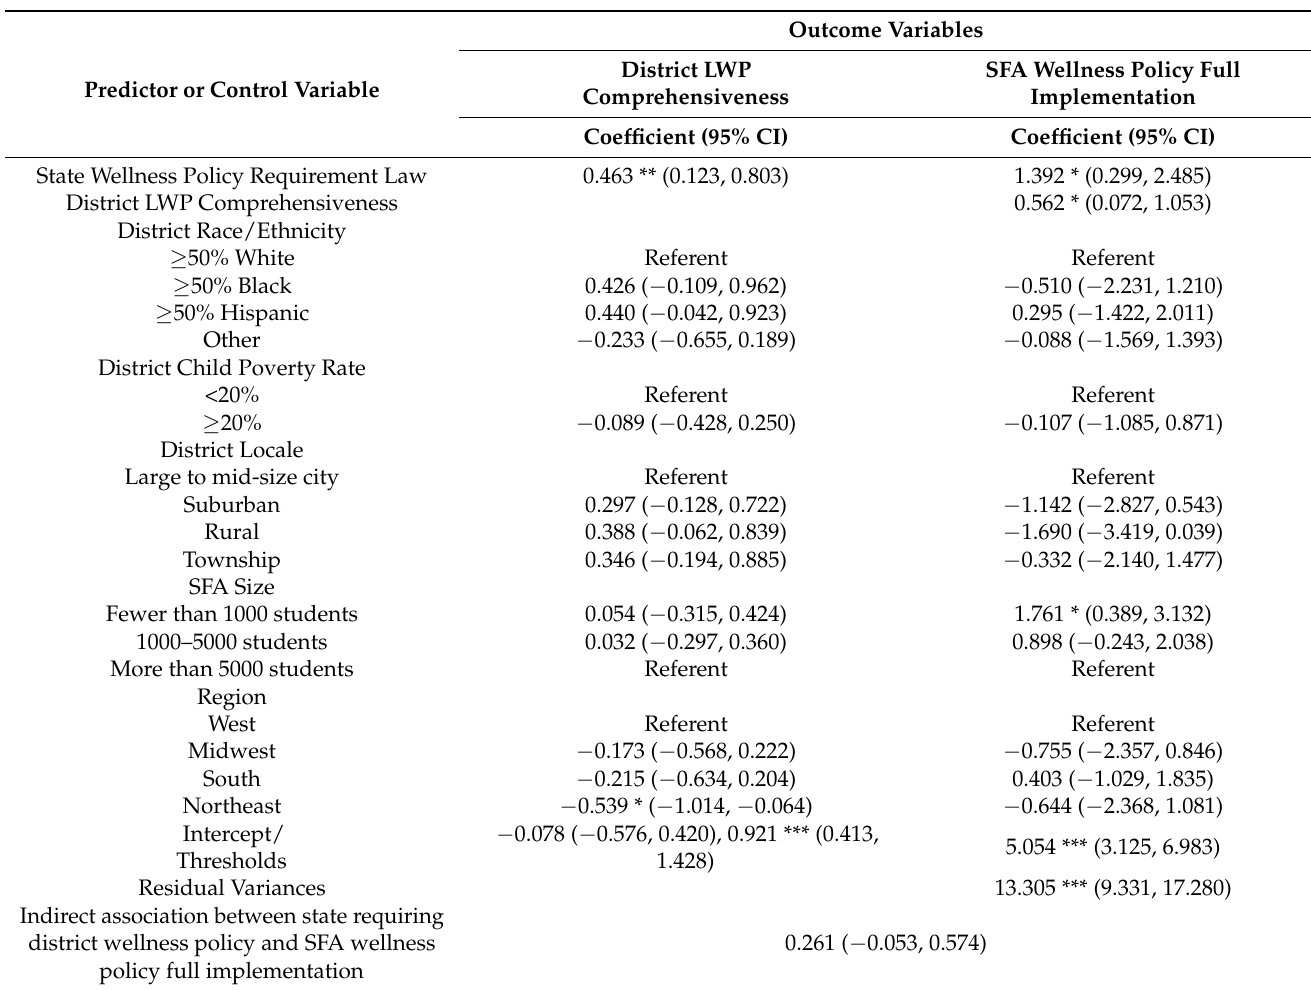
Table 2. Structural equation model linking state wellness policy requirement laws, district LWP comprehensiveness, and SFA wellness policy full implementation.